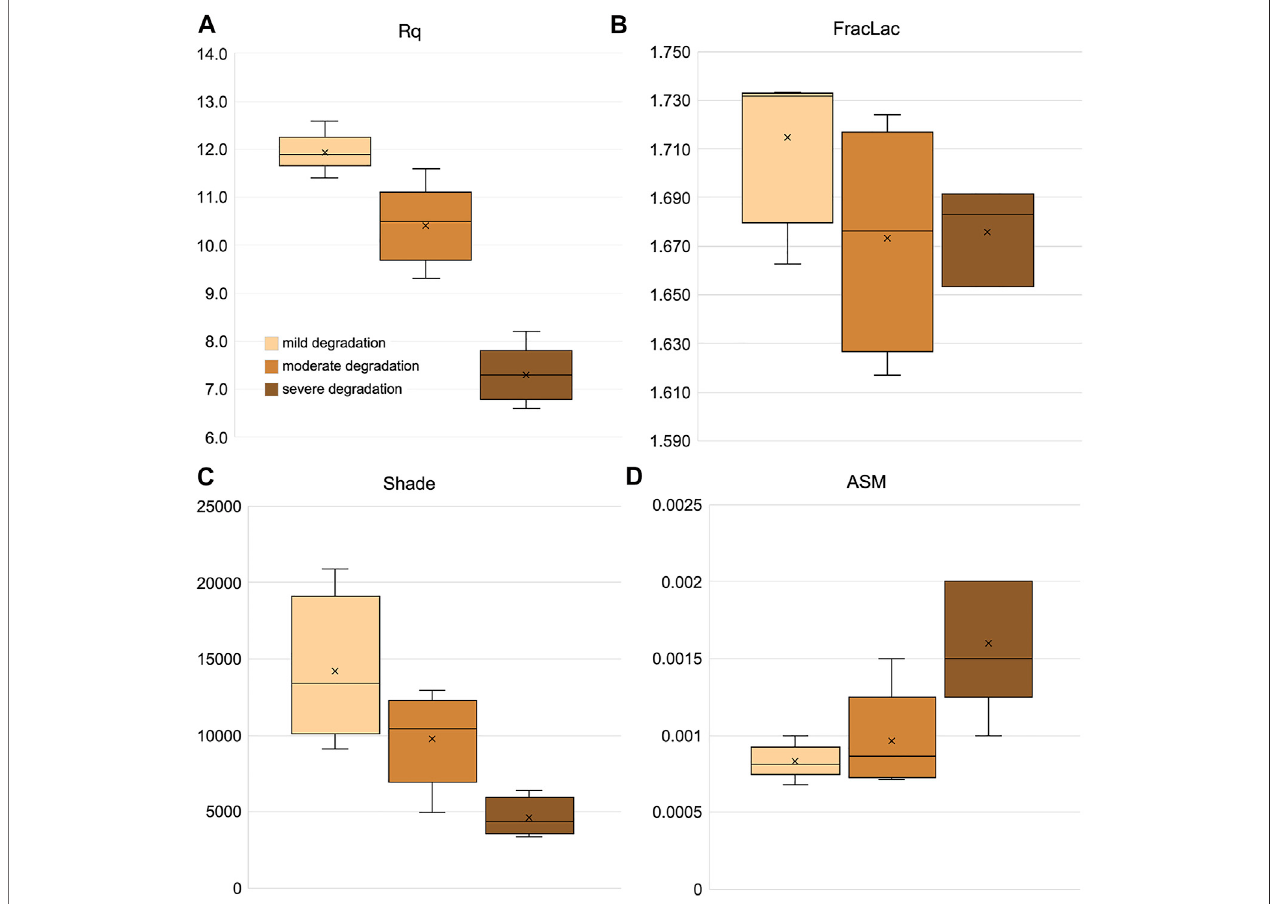
FIGURE 10 | A subset of textural feature image analysis results from bale core samples taken corn stover bales with variable biological degradation. (A) Rq is the root mean square deviation. (B) FracLac is the local connected fractal dimension. (C,D) Shade and angular second moment (ASM) are grey-level co-occurrence matrix analysis